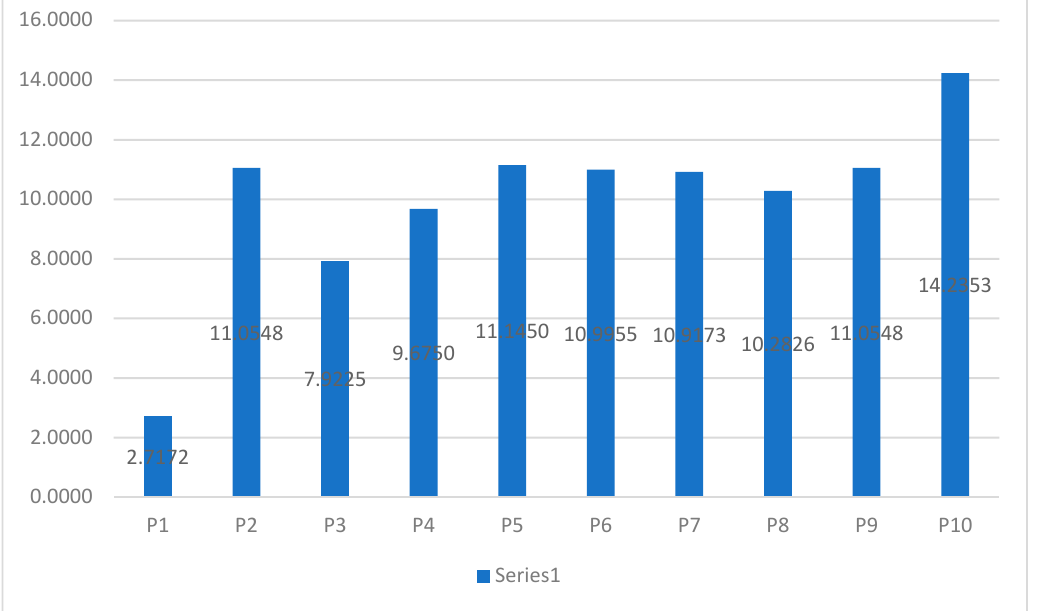
Figure 11. Priority KOSGEB support models for group A (effective firms) companies.